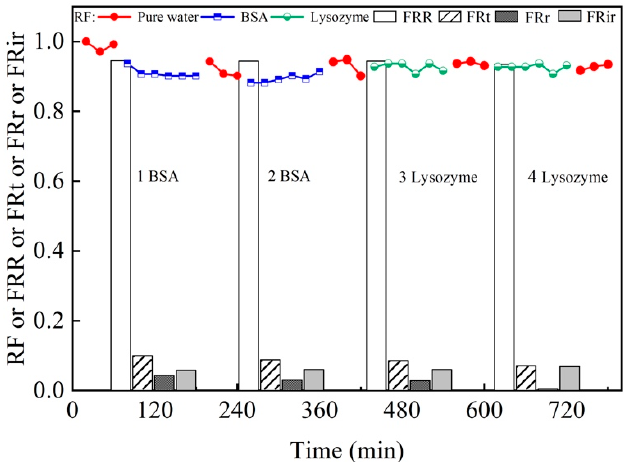
Figure 13. RF and antifouling property (FRR, FRt, FRr, and FRir) of the M5